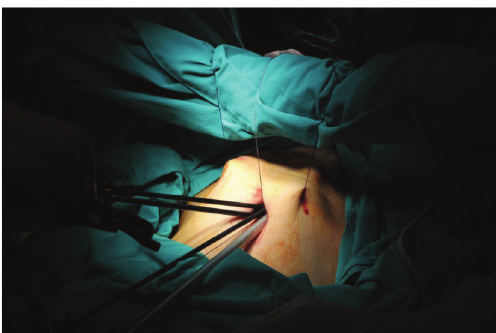
Figure 4: The abdominal wall was elevated by an assistant, and the surgeon tied the sutures over the preprepared sterile ether screen. Multiple instruments without their trocars can be used in the same single